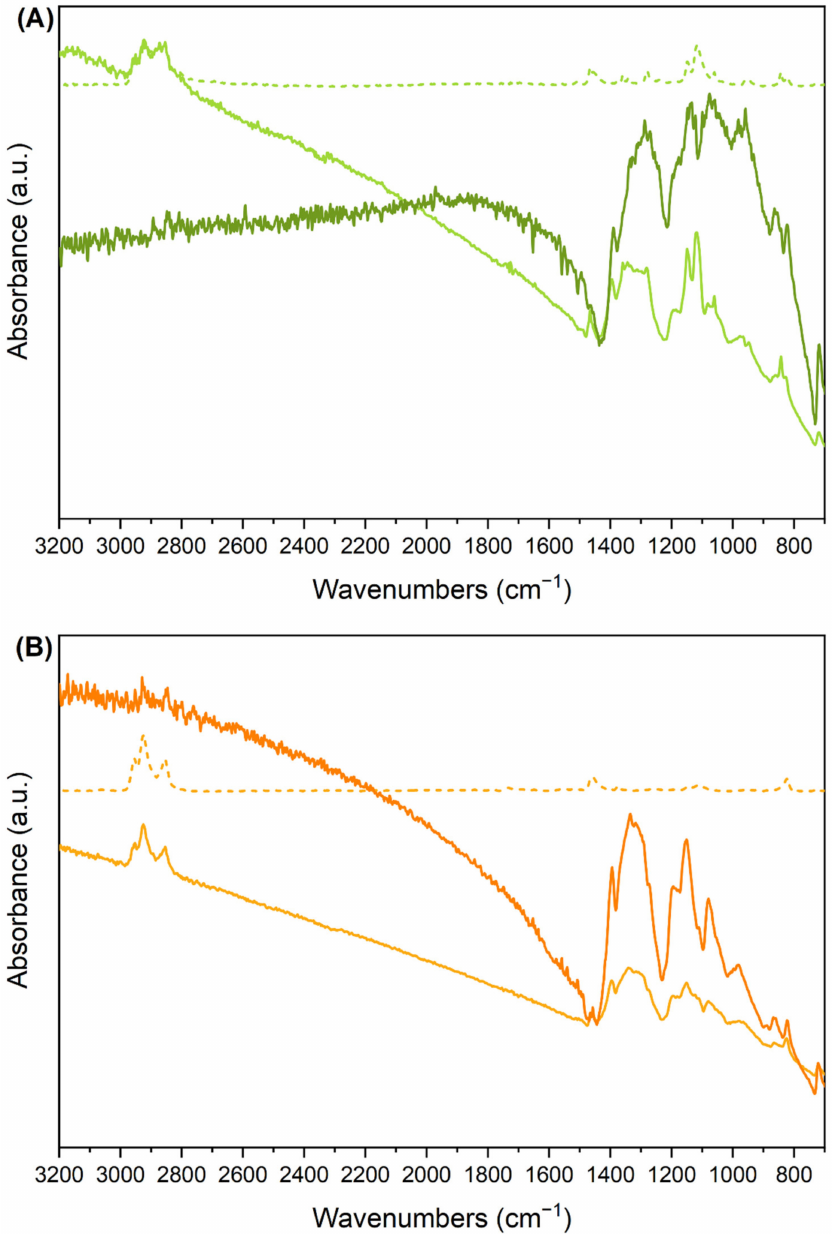
Figure 7. Infrared spectra of iodine-doped macroscopically aligned nanofibres recorded in polarised light. Panel ( A ), spectra of P3HT:PEO nanofibres; Panel ( B ), spectra of P3HT nanofibres. The darker lines refer to spectra recorded with light polarised parallel to the main axis of the nanofibres; lighter lines refer to spectra recorded with perpendicular polarisation. As a reference, dashed spectra of the pristine material recorded with perpendicular polarisation are